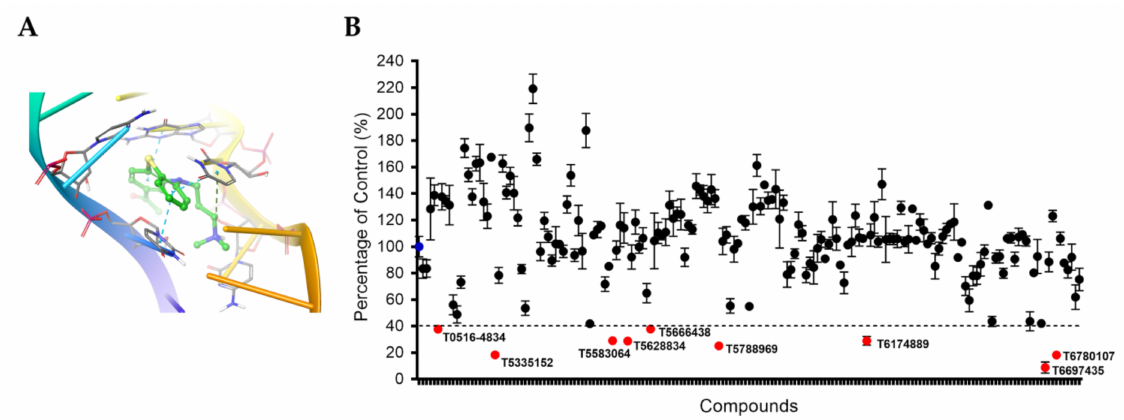
Figure 1. Screening of TAR RNA-targeting compounds. ( A ) Complex of acetylpromazine with TAR RNA (PDB ID: 1LVJ). ( B ) High-throughput screening for one round of HIV-1 infection. HIV-1-LUC-G infected CEM T cells were seeded in 96-well plates and treated with 10 µ M concentration of compounds. DMSO represents 100% (blue) and percentage of inhibition was calculated for each compound. In red, compounds are shown that achieved more than 60%